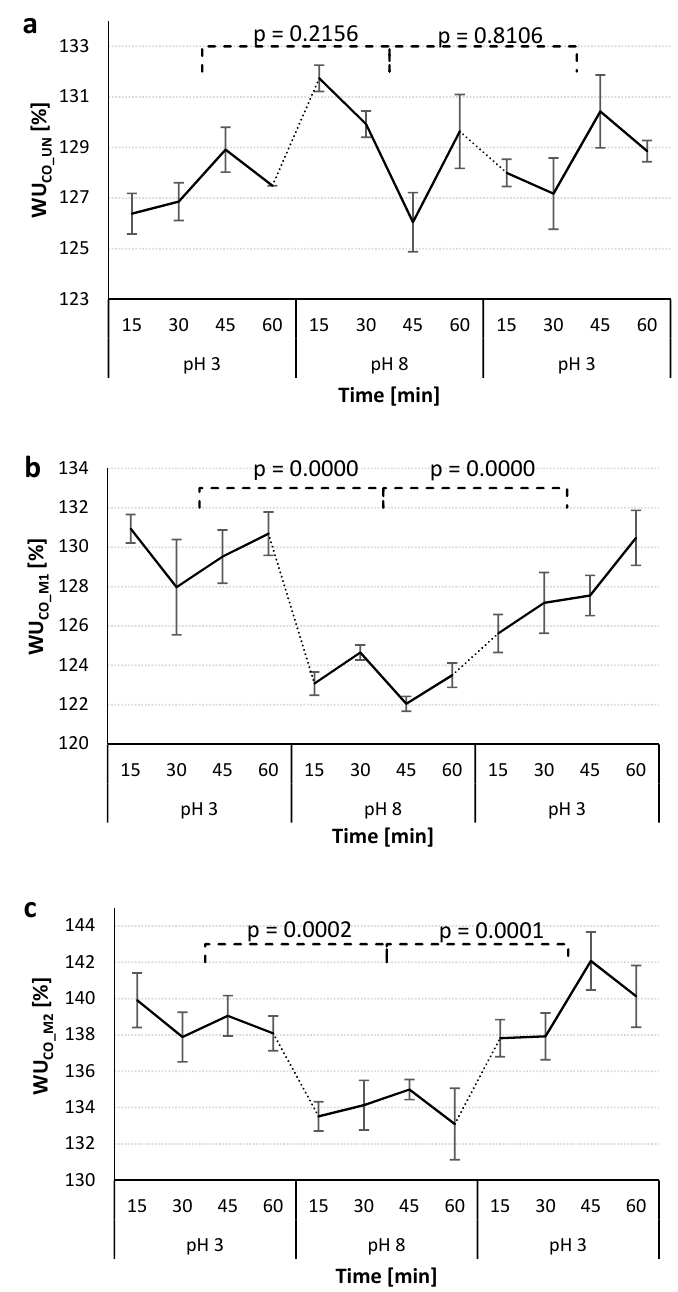
Figure 9. Water uptake (WU) of the studied CO_UN ( a ), CO_M1 ( b ) and CO_M2 ( c ) samples determined each 15 min during alternating 1 h immersion of the samples in buffer solutions of pH 3 and pH 8.